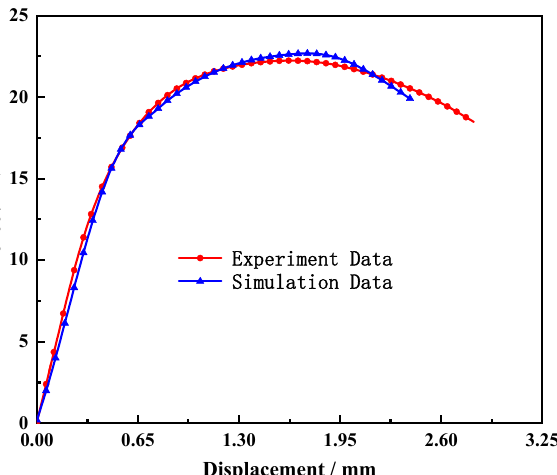
Figure 6. Comparison of load–displacement between simulation and smooth bar tensile test results (0.001 s − 1 ).